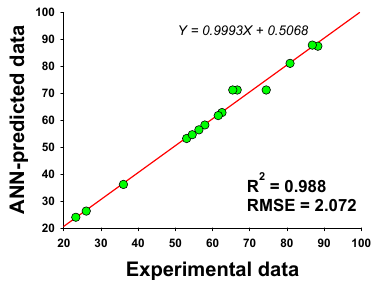
Figure 4. The performance of constructed ANN on data fitting. ANN performance was evaluated by a coefficient of determination ( R 2 ) and a root ‐ mean ‐ square error (RMSE). Residual values: ANN ‐ predicted values minus experimental values.